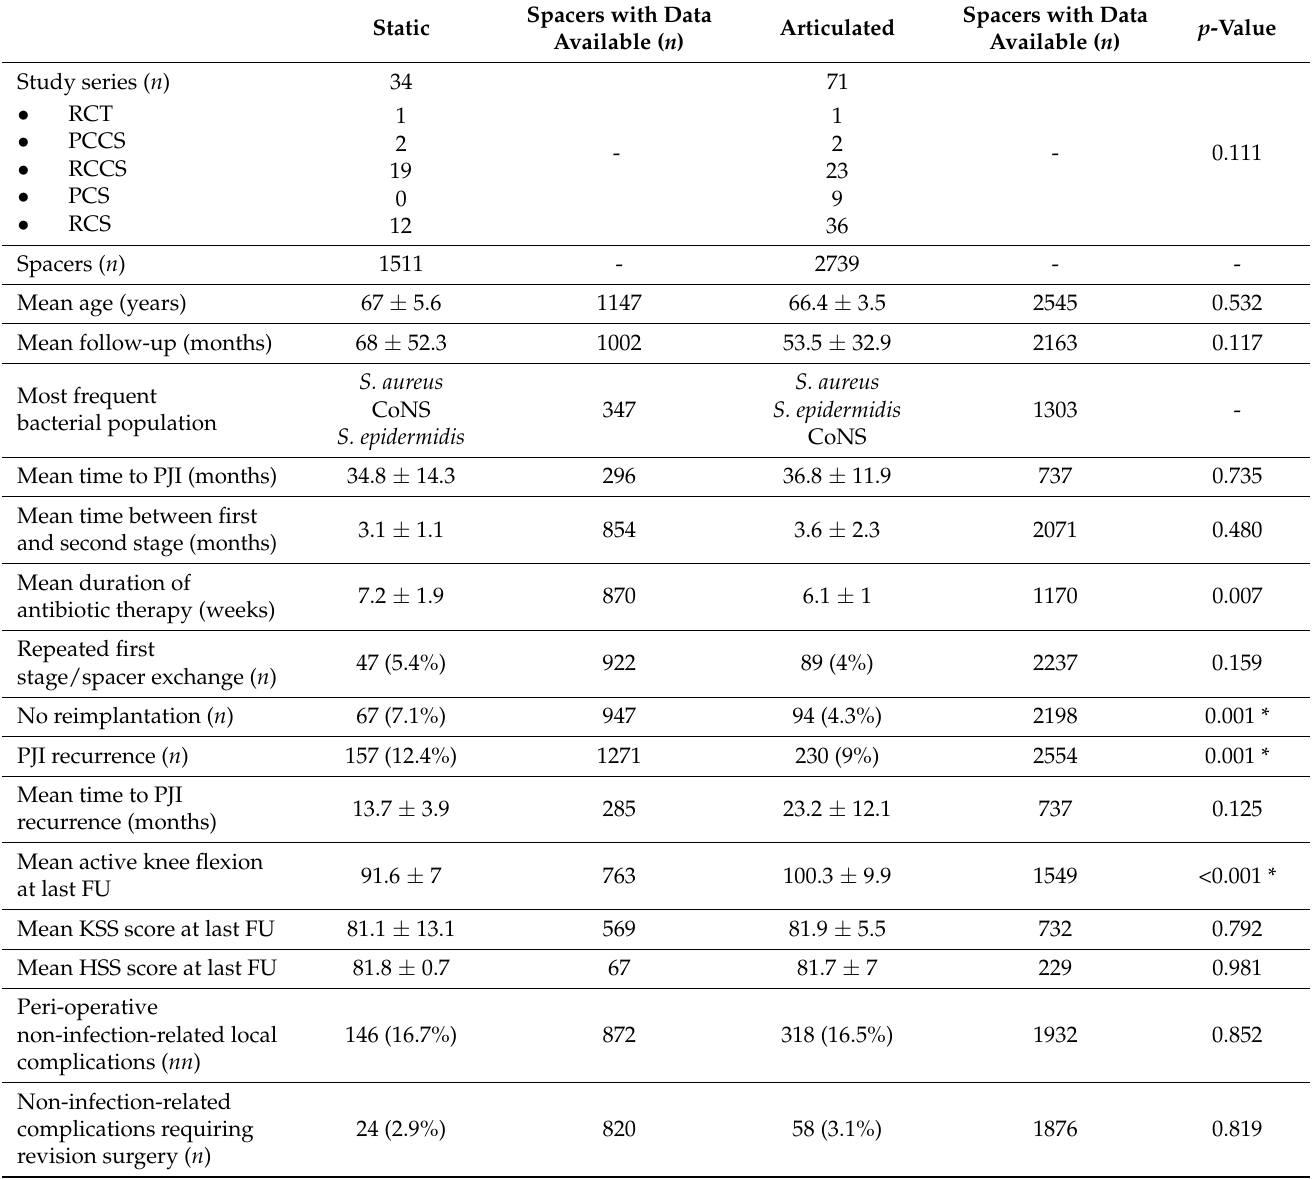
Table 3. Summarized data from the included studies of this review. Spacers with Data Available ( n )